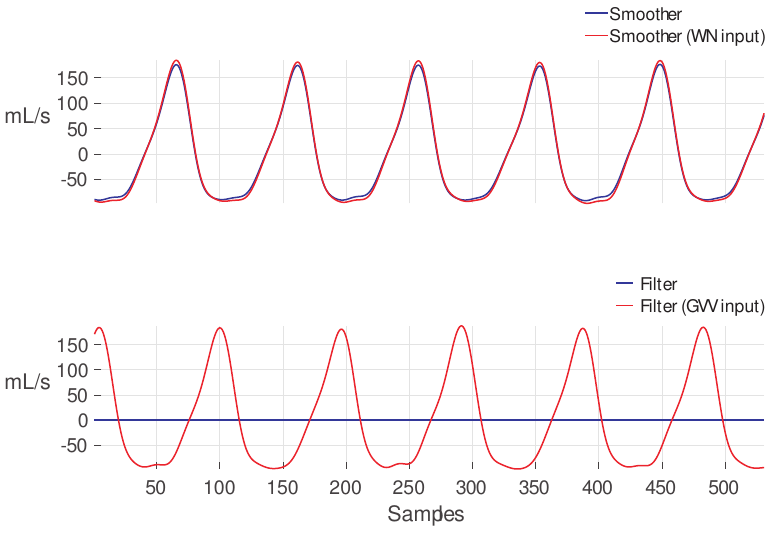
Figure 4. Top panel: GVV estimates ( ˆ x ( n − N + 1 | n ) ) using A (blue) and A lp (red). Bottom panel: GVV estimates ( ˆ x ( n | n ) ) using A (blue) and A lp (red).